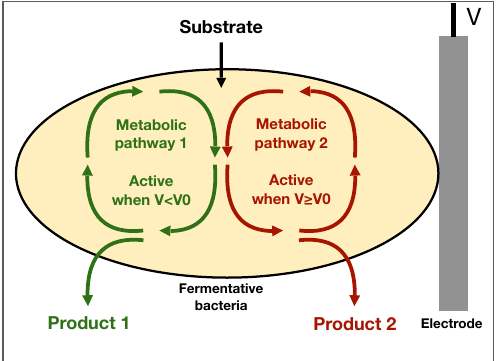
Figure 1. Scheme of the switching between the fermentation behaviors of a fermentative bacteria depending on the electrode potential V